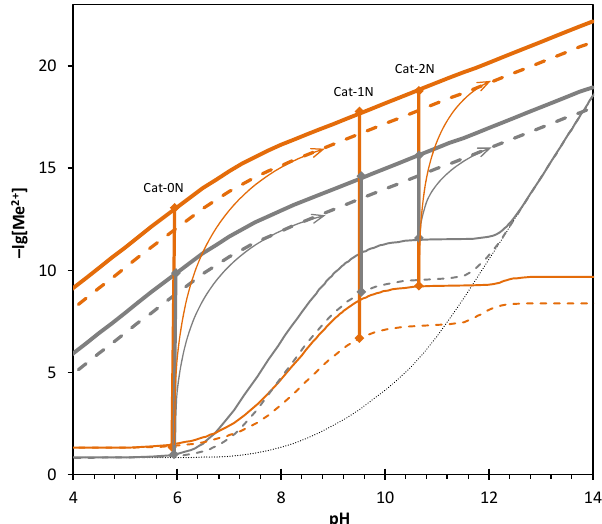
are indicated in Figure 6 by thin solid and dashed lines for the excess ( T NH3 = 3 M) or stoichiometric amount of ammonia ( T NH3 = 1.5 M), respectively. The orange and grey colors indicate the values for cadmium (II) and zinc (II) ions, respectively.